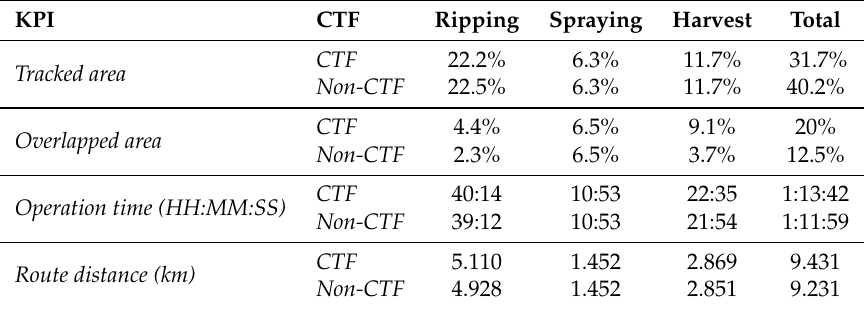
Table 3. Key performance indicators for CTF vs. non-CTF.